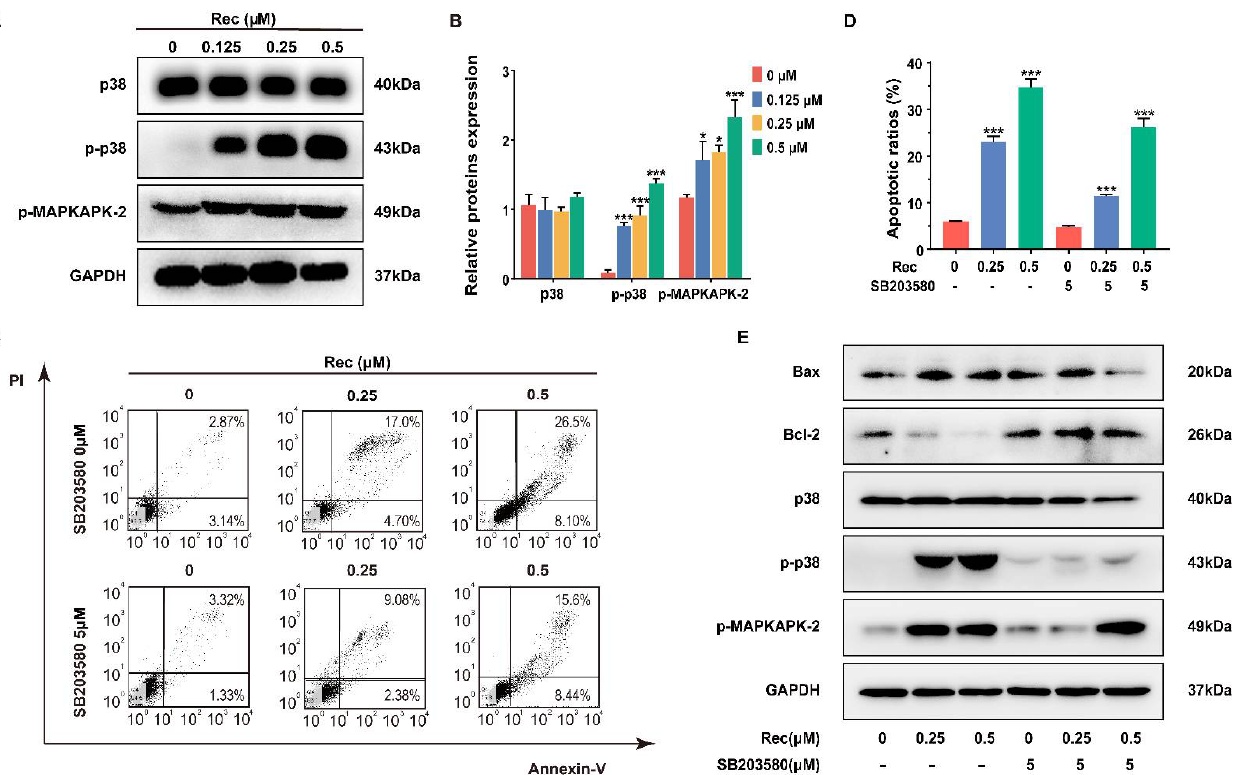
Figure 4. Resistomycin induced apoptosis by activating p38 MAPK signaling in vitro, which was impeded by using SB203580, an inhibitor of p38 MAPK. ( A , B ) The expression changes in the p38 MAPK pathway in HepG2 cells were triggered by resistomycin treatment for 24 h and relative protein expressions were detected via western blotting. ( C , D ) Flow cytometry analysis of the numbers and percentage of apoptotic cells treated with resistomycin for 24 h after 5 μmol/L SB203580 was added to the HepG2 cells. ( E ) HepG2 cells pre-treated with or without 5 μM SB203580 for 1 h and exposed to various concentrations of resistomycin for another 24 h, then analyzed by western blotting to measure the alteration of relative protein expressions. * p < 0.05 and *** p < 0.001 versus 0 μM resistomycin.